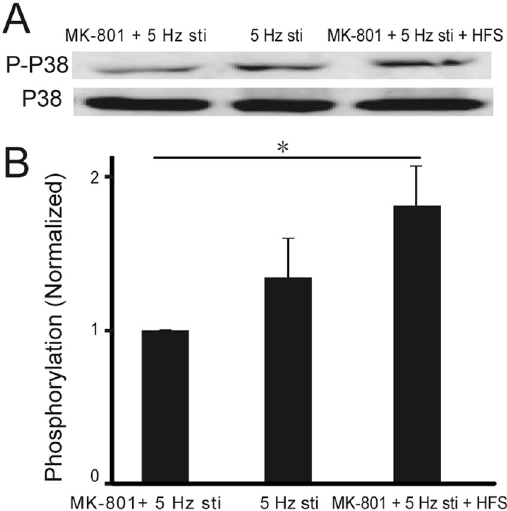
Figure 6. HFS induced phosphorylation of p38 MAPK when S-NMDARs are blocked. ( A ) Western blots of the indicated phosphoproteins in CA1 neurons. ( B ) The summary histograms quantifying relative immunoreactivity. Blots are cropped for clarity; full blots are shown in the Supplementary file. All data points represented as means ± SE, n = 3, * p <